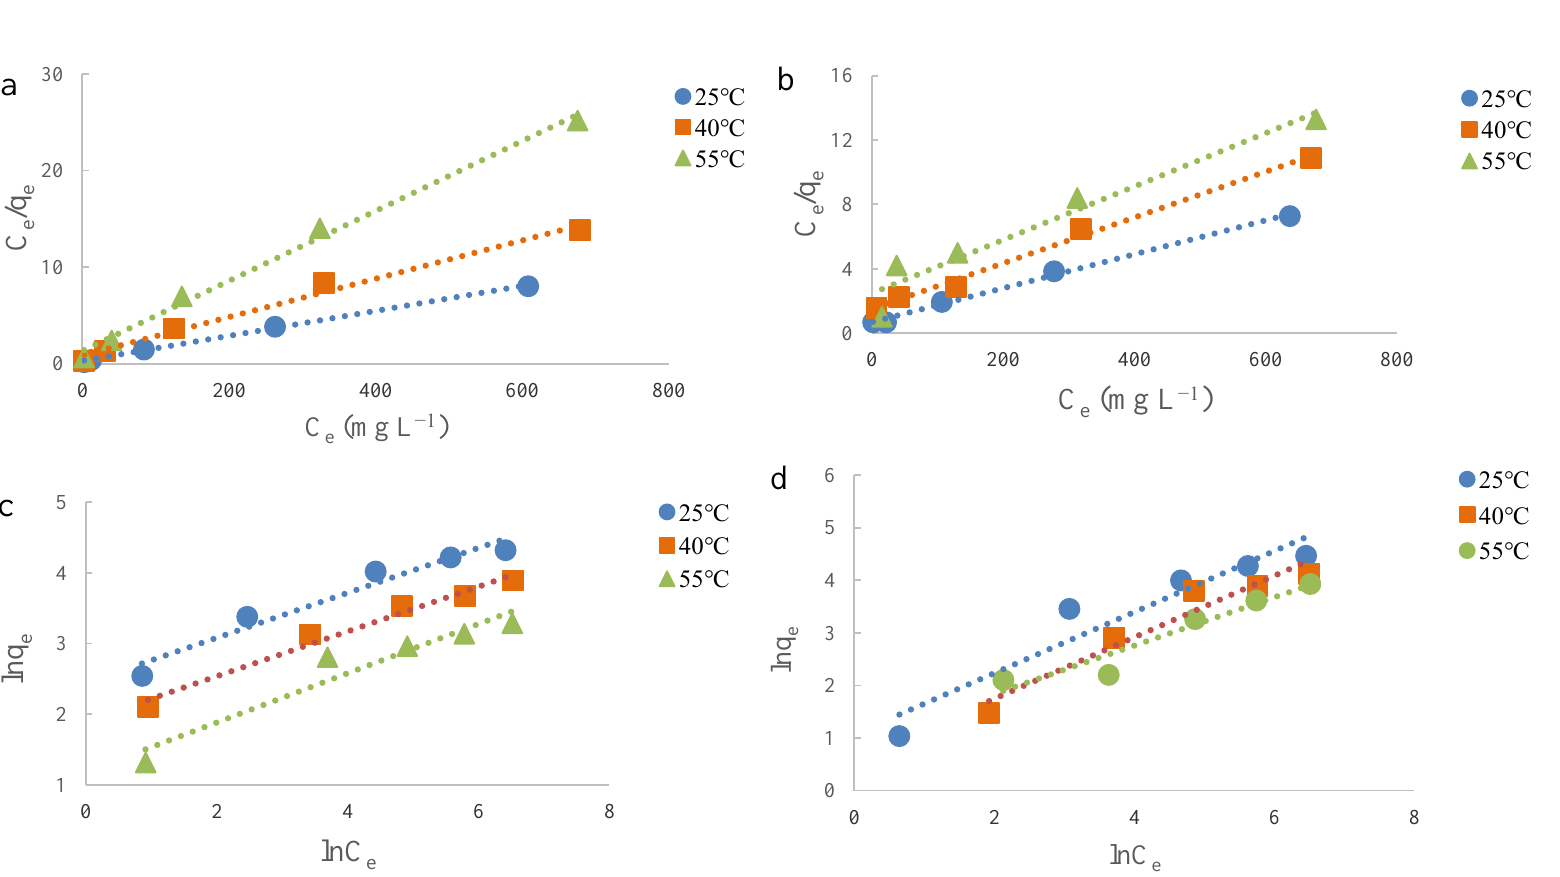
Figure 5. Plots of Langumuir isotherms of EGCG onto NHP ( a ), EP ( b ) and Freundlich isotherms of EGCG onto NHP ( c ) and EP ( d ) at different temperatures.